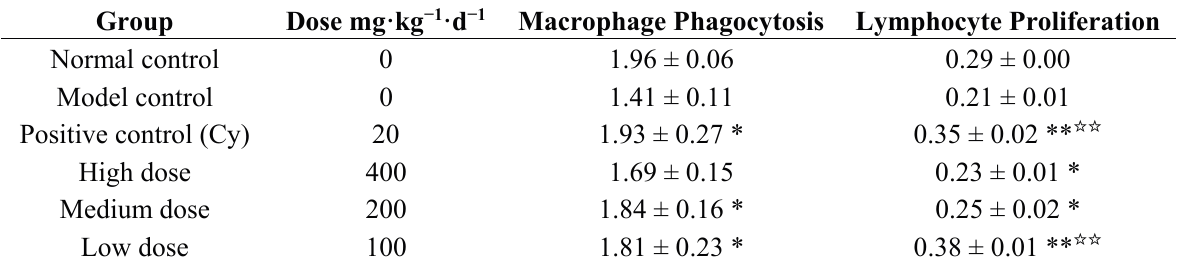
Table 3. Effect of BBP3-1 on the immune cells function of m ice ( x ± s, n =